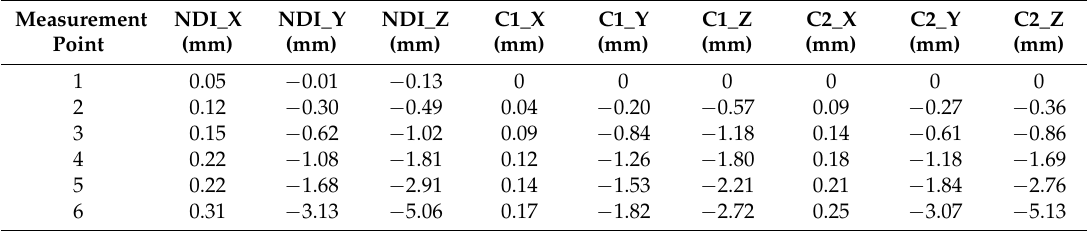
Table 9. Deformation displacement by NDI measurement and reconstruction with the C1 and C2 schemes in marker point for middle load condition.